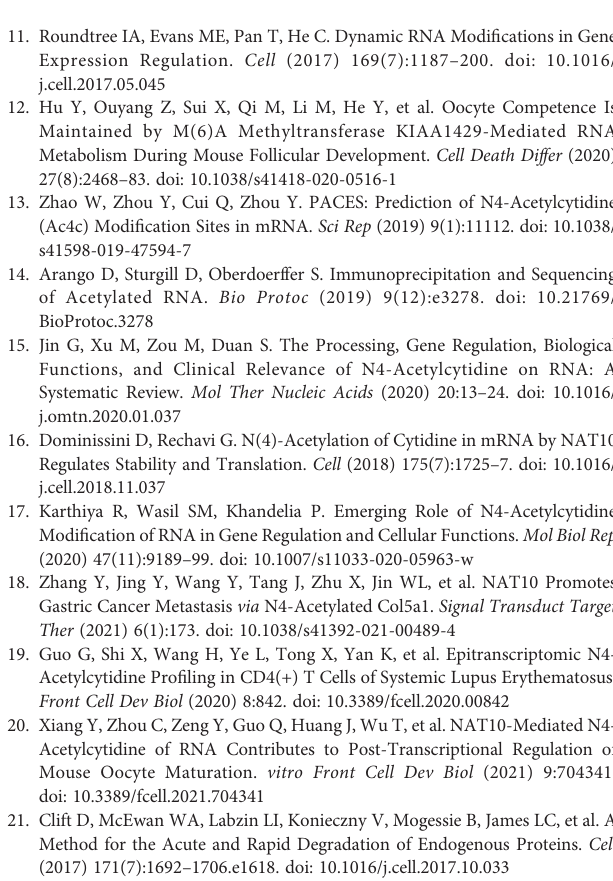
Supplementary Figure 1 | The modulation of OGA level after NAT10 knockdown induced a compensatory regulation of OGT. Affected by NAT10 knockdown, the decreased level of OGA resulted in the downregulation of OGT in